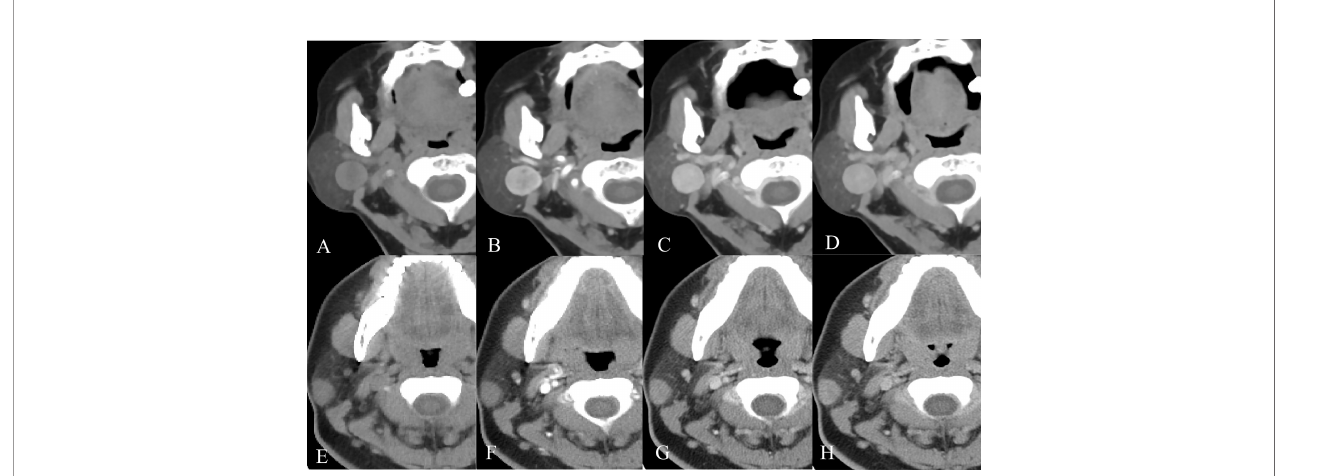
FIGURE 5 | Example images of four-phase CT scans of PA and BCA. (A-D) Axial CT images of a 68-year-old female patient with a right-sided painless neck mass in the plain, arterial, venous, and delayed phases, separately. After CT examination, surgical pathology con fi rmed that the mass was BCA. (E-H) Axial CT images of a